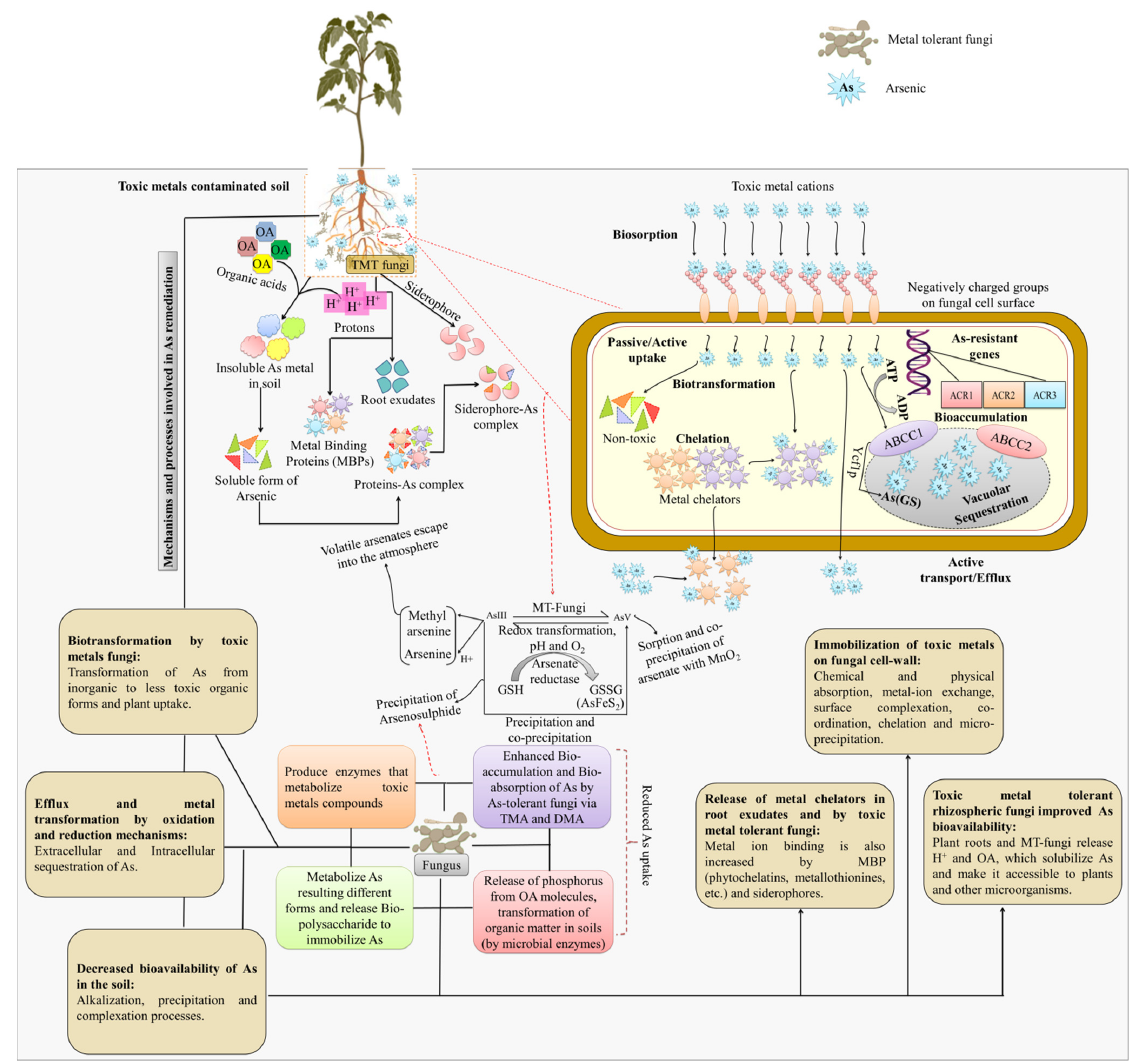
Figure 6. Mechanism of arsenic tolerance in fungi at the cellular level. Organic acids and protons are produced by MT-fungi, which transform the insoluble form of As metal into a soluble form. They were then able to bind MBPs, generating a complex that plants could easily absorb. Redox conditions influence the equilibrium between AsV and AsIII in the circulating solution of soil. Once inside the plant, arsenate reductase reduces AsV to AsIII, while GSH is oxidized to GSSG. In yeast and several fungal cells, the Acr2p arsenate reductase uses glutathione oxidation to convert AsV to AsIII (GSH to GS). Two routes for eliminating cellular AsIII include extrusion via the plasma mem- brane carrier Acr3 or conjugation to glutathione (As(GS) 3 ), which is sequestered into vacuoles by the ABC transporter Ycf1p . As—Arsenic; TMT—Toxic metal tolerant; OA—Organic acids; OM— Organic matter; H + —Protons; MBPs—Metal binding proteins; AsIII—Arsenite; AsV—Arsenate; GSH—Glutathione; GSSG—Glutathione disulfide; AsFeS 2 —Arsenic pyrite; TMA—Trimethyl ar- sine; DMA—Dimethylarsinic acid; ATP—Adenosine triphosphate; ADP—Adenosine diphosphate; ACR —Arsenic compounds resistance; ABCC—ATP binding cassette subfamily C transporter; Ycf1p —Yeast cadmium factor-1. 5.2. Chelation of Metals Another toxic metals resistance technique is metal ion detoxification or metal chela- tion. In response to toxic metals stress, fungi produce chelating molecules, which bind to